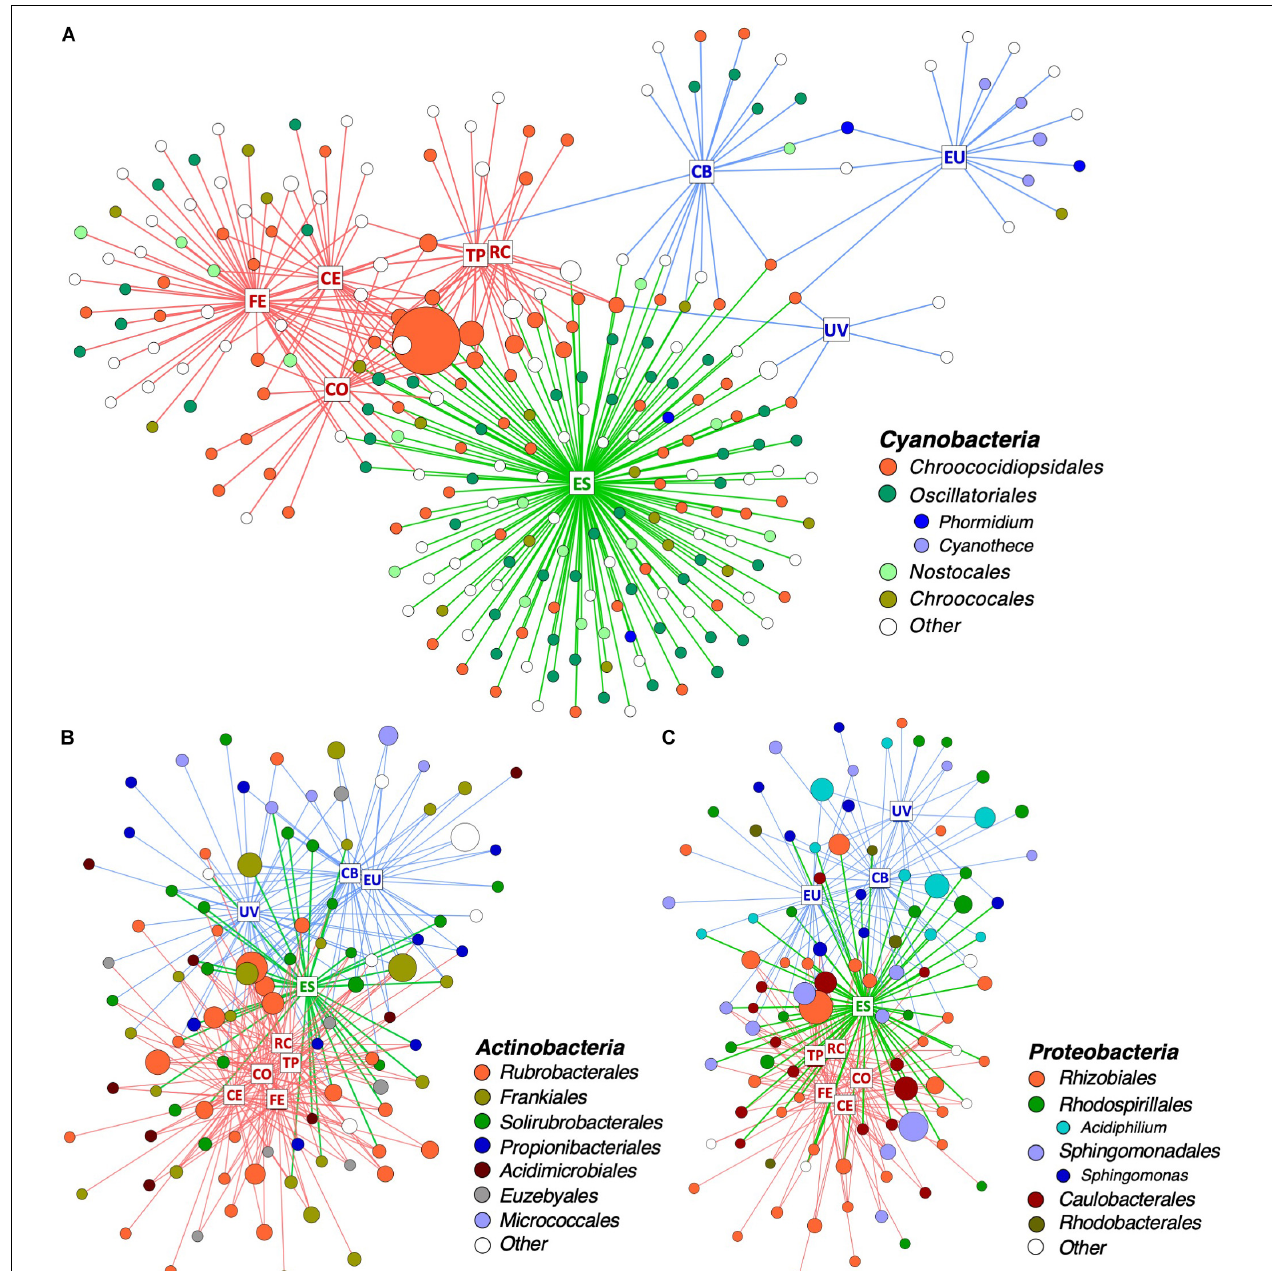
FIGURE 5 | Distribution of OTUs across desert sites. Bipartite network of (A) all Cyanobacteria and the 100 (B) Actinobacteria and (C) Proteobacteria OTUs with highest proportion of reads. Squares represent sites and are labeled with site name: RC, Ramon Crater; TP, Timna Park; CO, Namib Coastal; CE, Namib Central; FE, Namib Far East; ES, Escalante; CB, Cape Bounty; EU, Eureka; UV, University Valley. Edges are colored in according to the climate regime of their respective site: red = hot, blue = polar, and green = temperate. Circles represent OTUs and are colored by taxonomic order and genus. Singleton taxa and unassigned OTUs are colored in white. The size of each circle is proportional to mean relative proportion of that